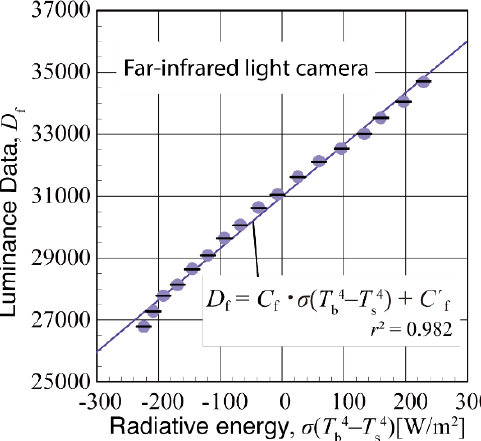
Figure 4. Data stored in far-infrared light camera versus measured radiative energy.